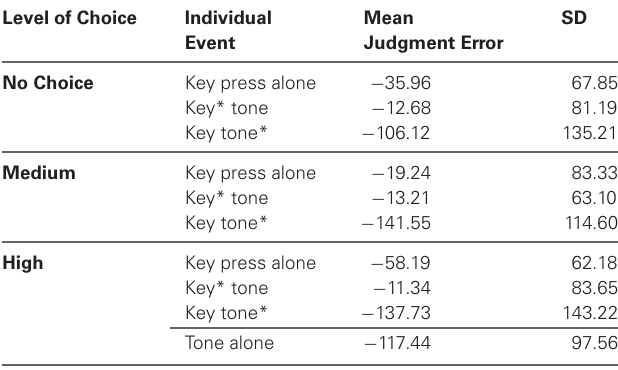
Table 1 | Mean judgment errors in each condition. Level of